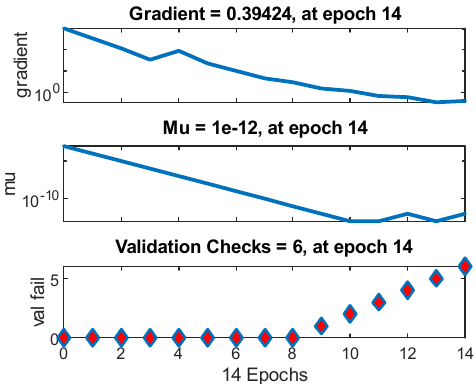
Figure 11. Training state through gradient and momentum (mu).